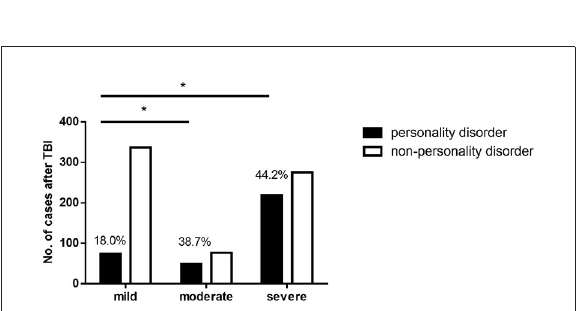
FIGURE1 The incidence rate of personality disorders after TBI. * The difference was statistically significant compared with mild group. The incidence rates of personality disorders after mild, moderate and severe traumatic brain injury were 18.0, 38.7, and 44.2%. The incidence rate of personality disorder after moderate TBI was significantly higher than that after mild TBI ( χ 2 = 23.056, P < 0.05), and the incidence rate of personality disorder after severe TBI was also significantly higher than that after mild